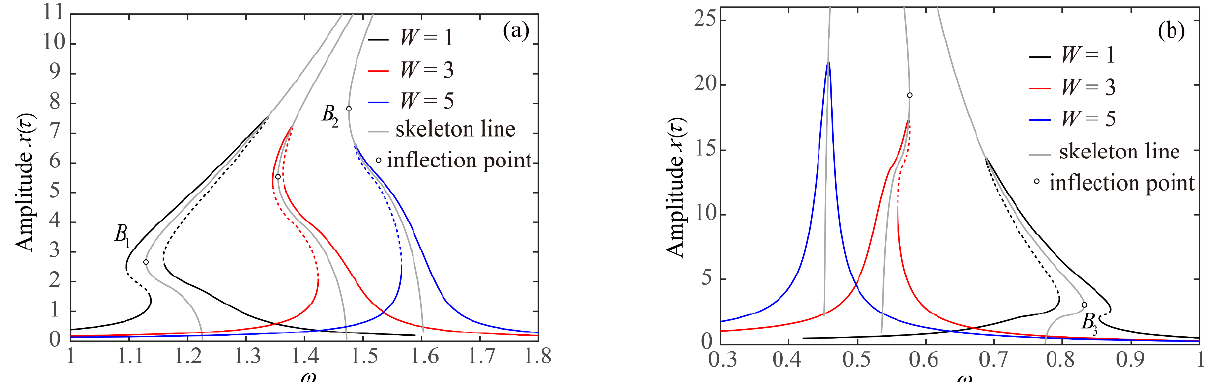
Figure 4. Influence of normal load W on α the frequency-response peak-to-peak curves of continuous system, ( a ) α = 1.5 and ( b ) α = 0.6.